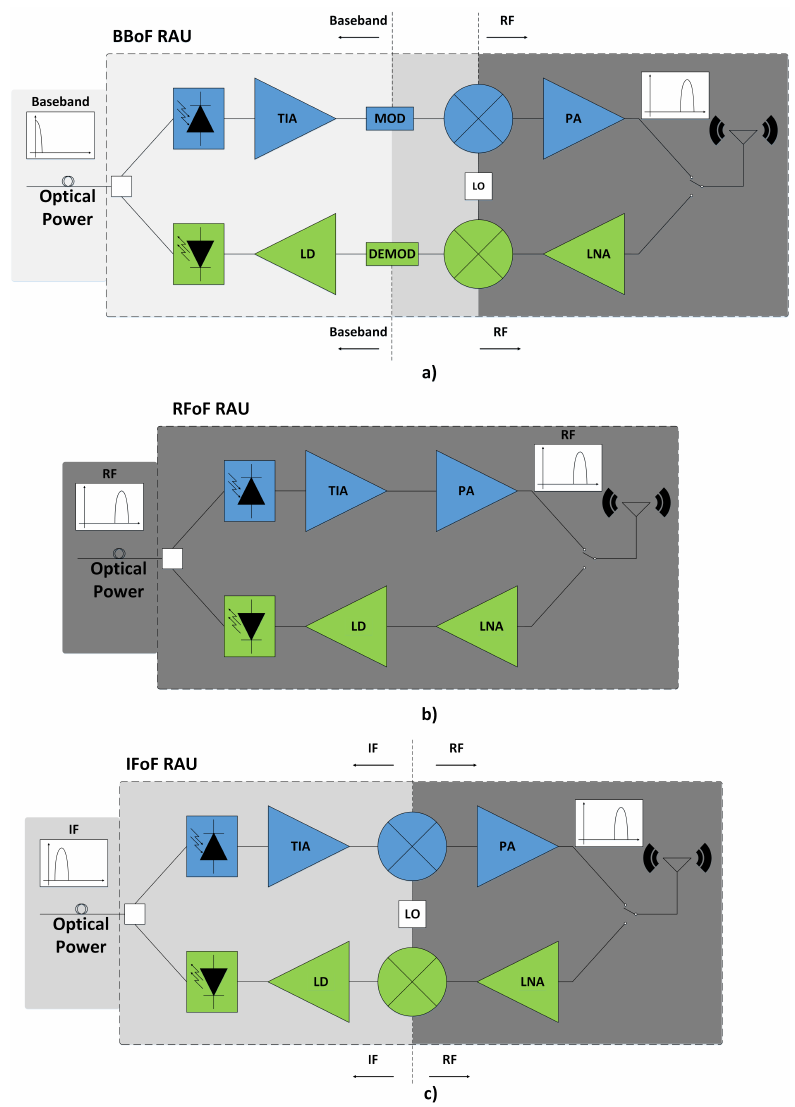
Figure 3. Conceptual scheme of remote antenna units for: ( a ) Baseband over fiber (BBoF). ( b ) Radio frequency over fiber (RFoF). ( c ) Intermediate frequency over fiber